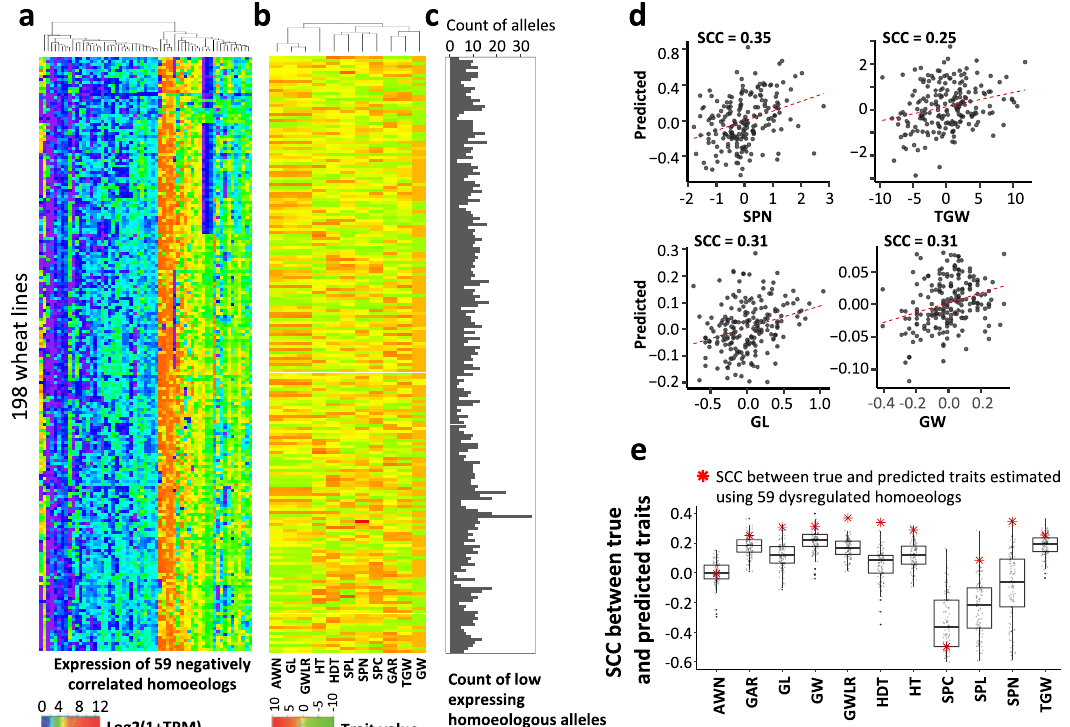
Fig. 6 Biased expression of homoeologous genes is linked with variation in productivity traits. a Hierarchical clustering of 198 wheat lines based on the levels of expression (log 2 (1 + TPM)) of 59 negatively correlated homoeologs. b Hierarchical clustering of 198 wheat lines based on the normalized productivity trait values. c The count of low-expressing alleles of homoeologs per line showing evidence of negative expression correlation in the population. d Correlation between the observed and predicted values for productivity traits. Predictions were performed using ridge regression based on expression data from the negatively correlated homoeologs. e Distribution of SCC between true and predicted traits from 100 replications of 10-fold cross- validation using the random sets of homoeologous genes and ridge regression modeling. Predictions generated using real-world data from negatively correlated homoeologs are shown by a red asterisk. Box shows the median and IQR. The end of the top line is the maximum or the third quartile (Q) + 1.5 × IQR. The end of the bottom line denotes either the minimum or the fi rst Q − 1.5 × IQR. The dots are more or less than Q ± 1.5 × IQR. Source data are provided as a Source Data fi